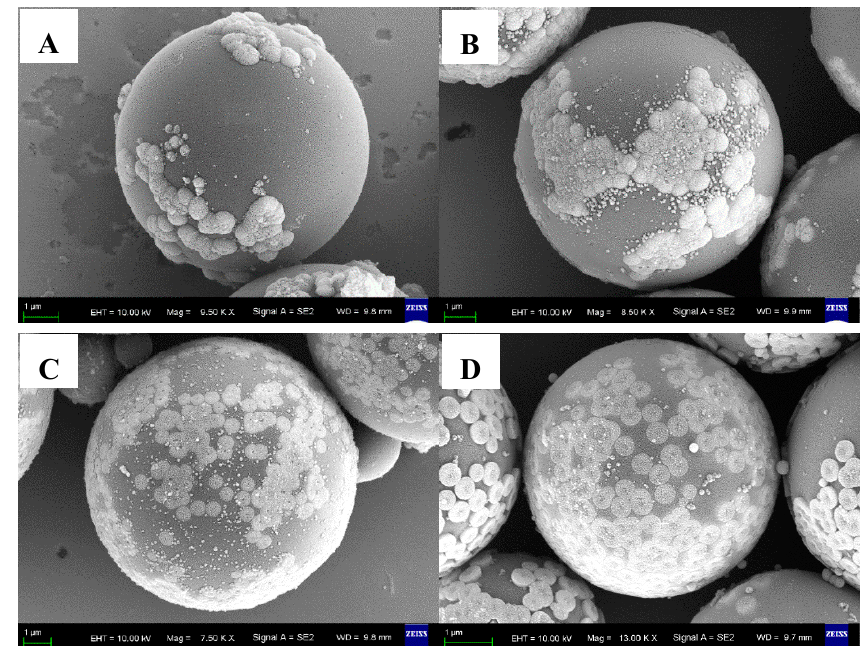
Figure 3. Images of the four P(MAA/St)/Fe 3 O 4 with different carboxyl content polymer microspheres: MP-1 ( A ); MP-2 ( B ); MP-3 ( C ); MP-4 ( D ).